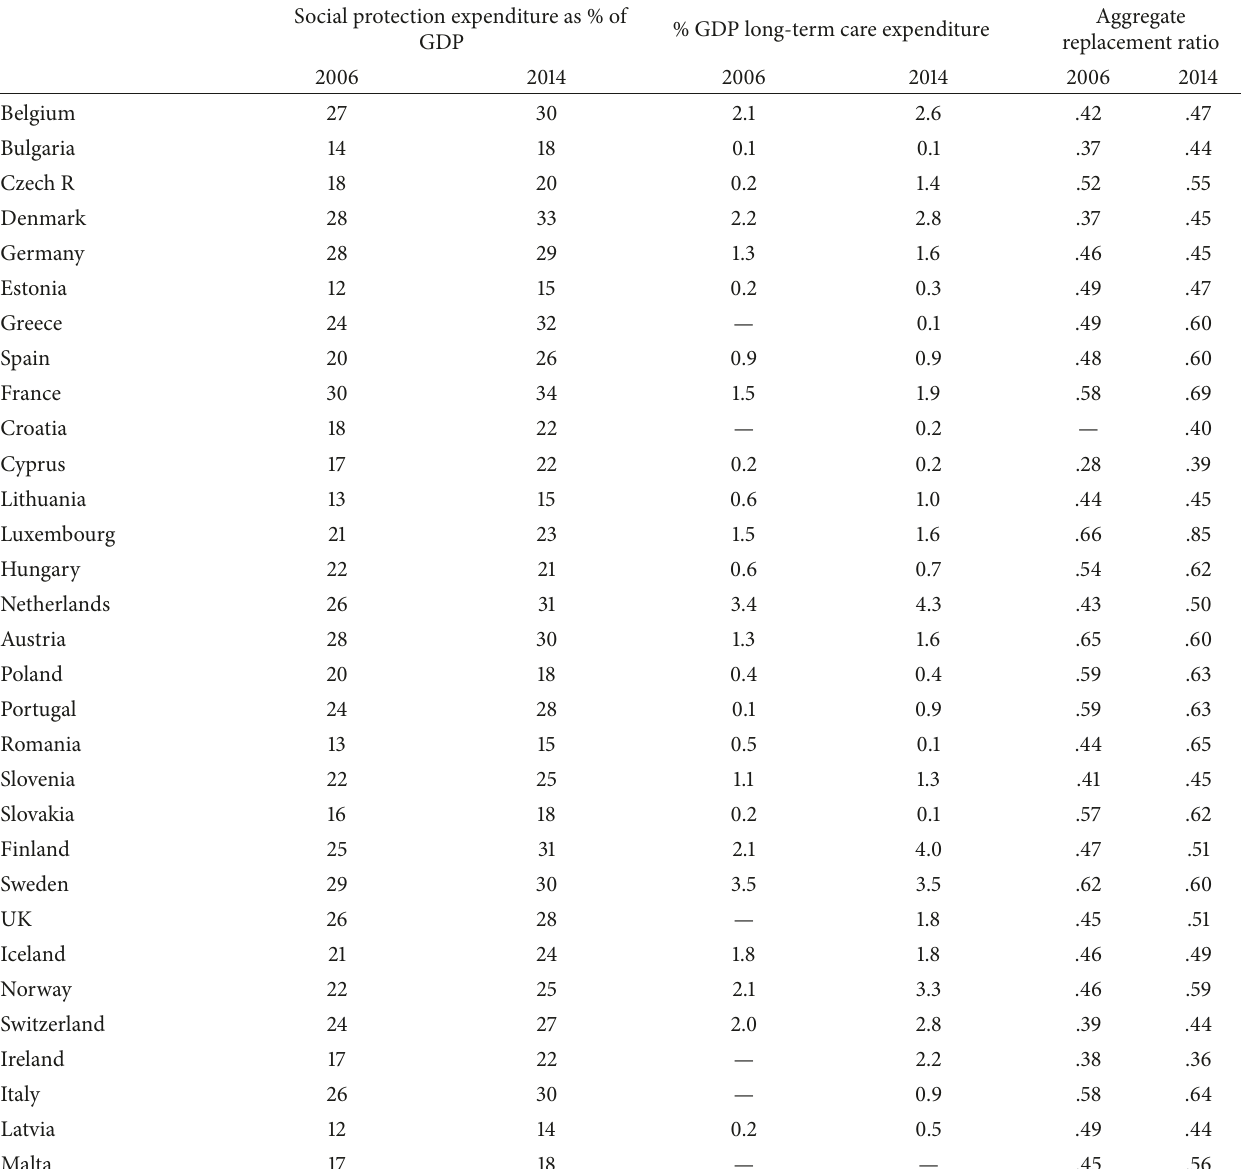
Table 3: Mean scores on the welfare indicators social protection expenditure as % of Gross Domestic Product (GDP), long-term care expenditure as % of GDP, and aggregate replacement ratio per country in 2006 and